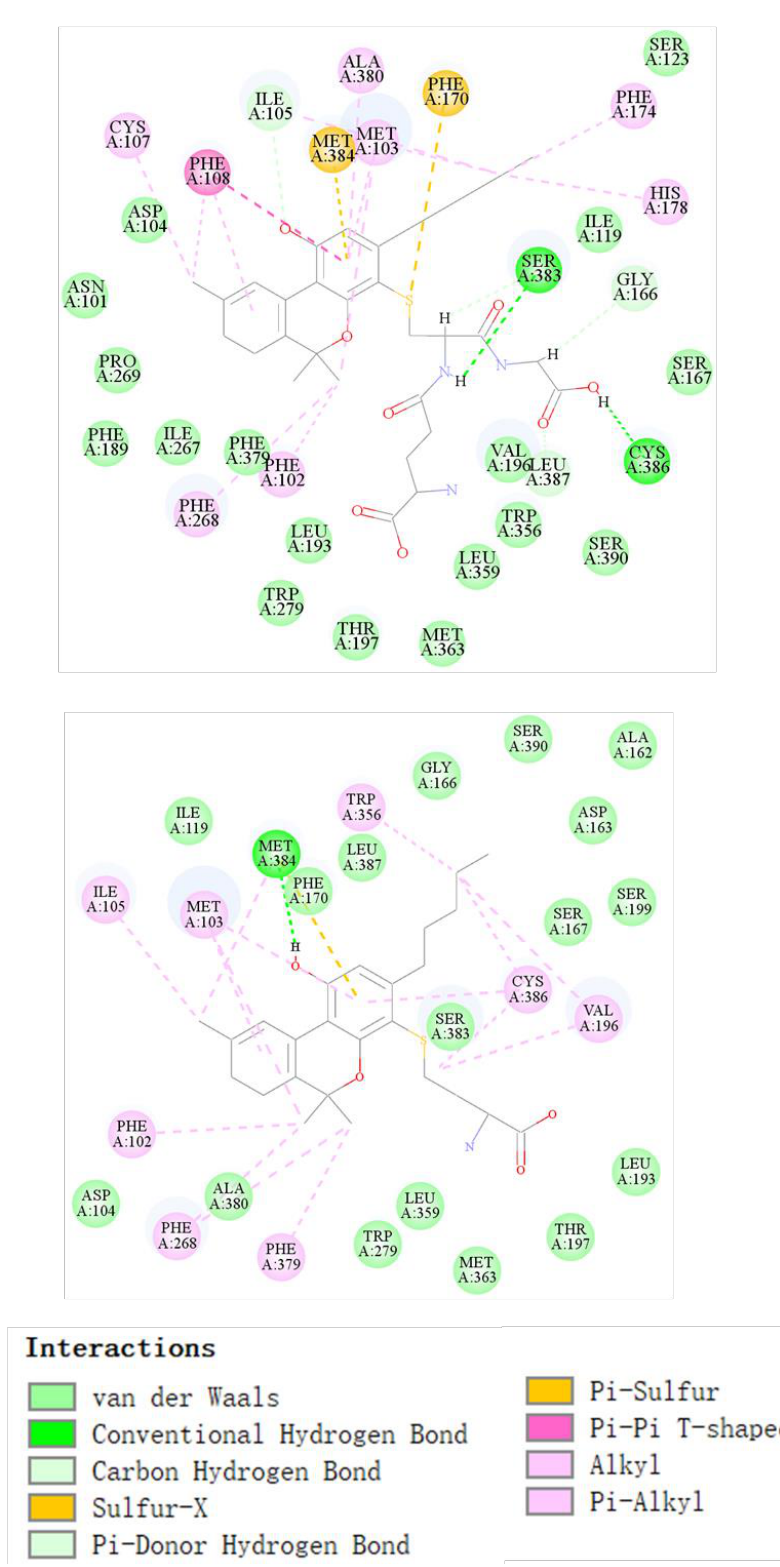
Figure 5. Molecular docking of THC conjugated with GSH (T29) and Cys (T31). The lowest energy docked pose and 2D interaction map in T29 ( A ) and T30; ( B ) binding site of the CB1 receptor. Active site residues involved in the interaction are represented in blue. The different colors represent the conjugated bond interactions between the target and ligand molecules.